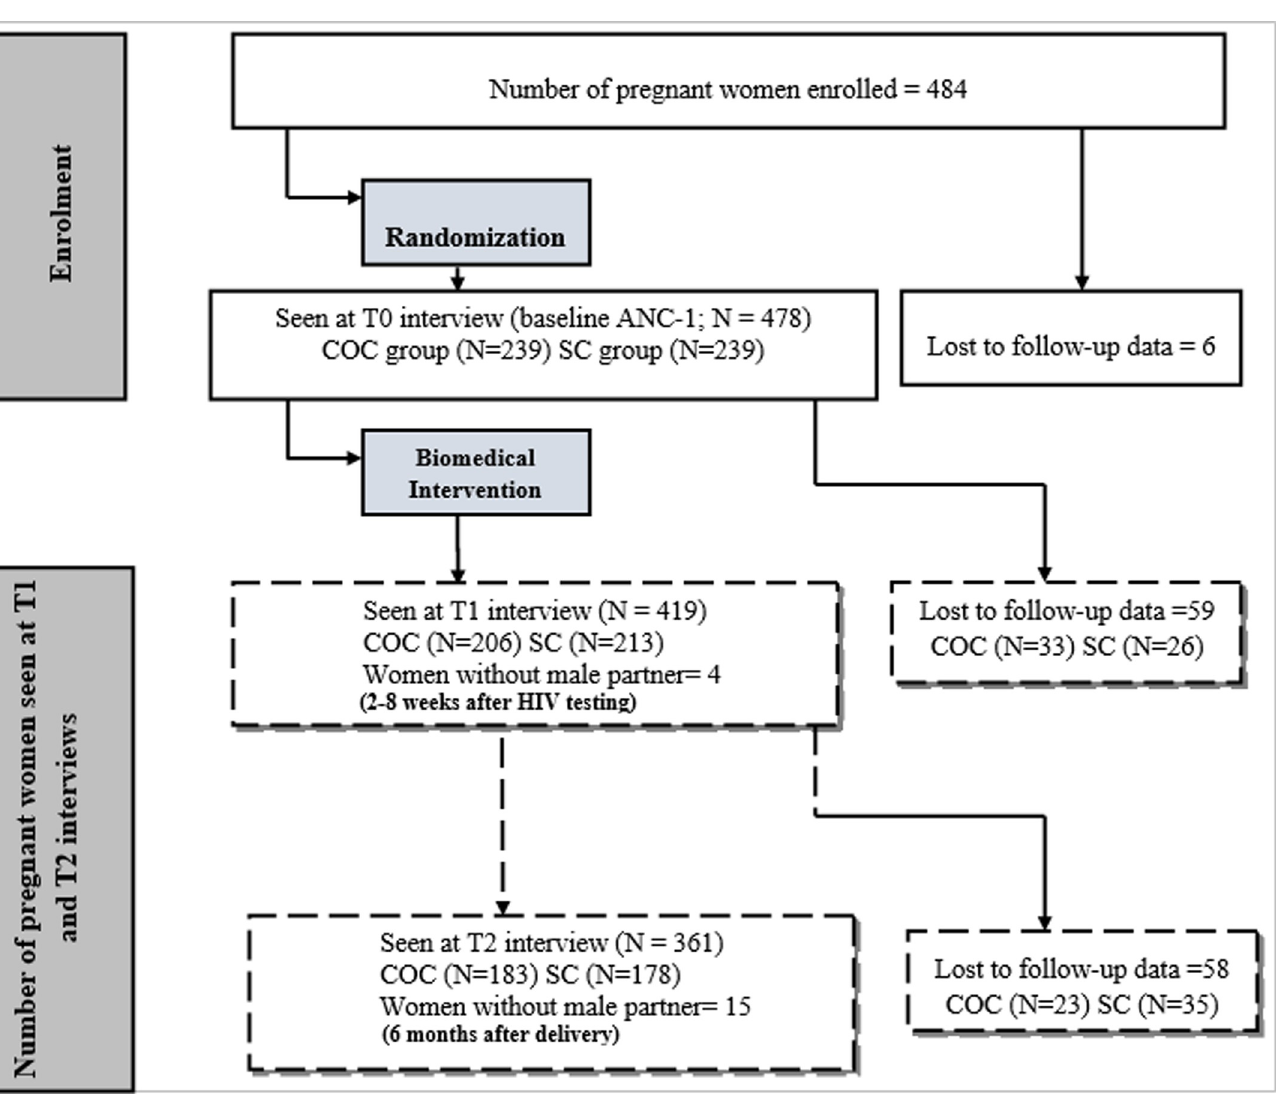
Fig 1. Flowchart of enrolment and follow-up within the cohort of pregnant women in Cameroon, ANRS 12127-12236/Prenahtest trial (2009–2011).